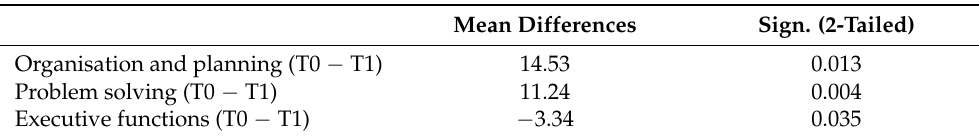
Table 11. Student’s t -test for difference between averages scores for paired samples of the TOL test